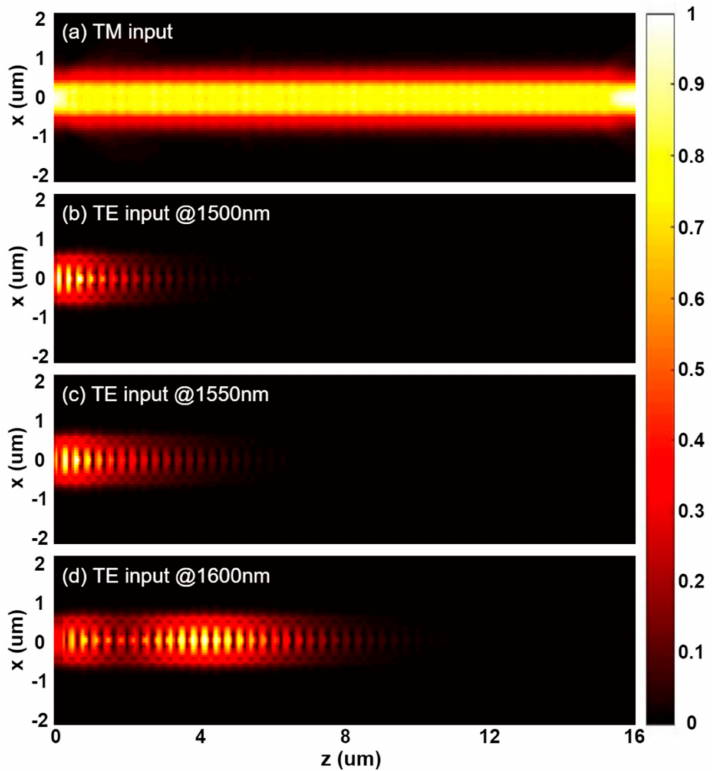
Figure 5. Power propagation of ( a ) TM polarization state at 1550 nm; ( b ) TE polarization state at 1500 nm; ( c ) TE polarization state at 1550 nm; ( d ) TE polarization state at 1600